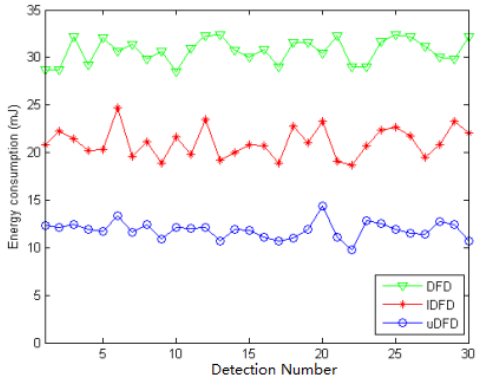
Figure 15. Energy consumption of each detection under 80 working node conditions.